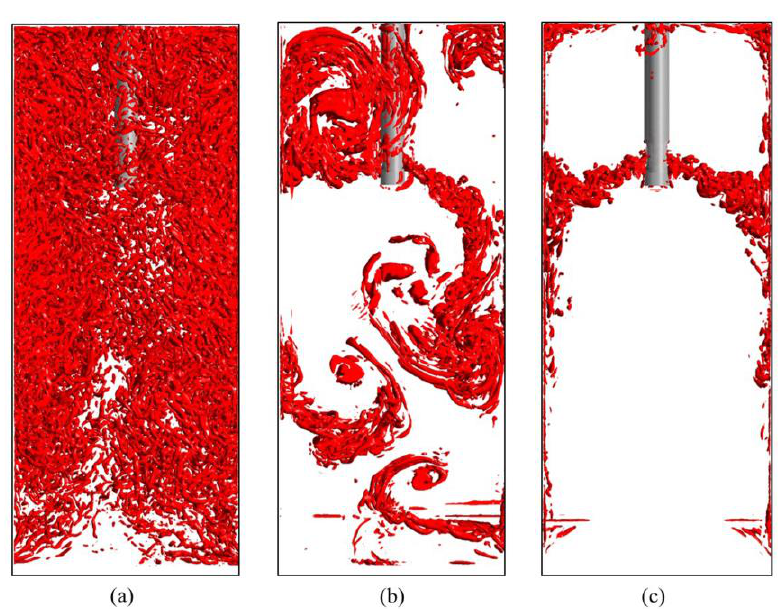
Figure 5. Instantaneous iso-surfaces of Q-criterion (500 1/s 2 ): ( a ) No EMBr (electromagnetic brake); ( b ) EMBr with electrically-insulated walls; ( c ) EMBr with electrically-conducting walls.